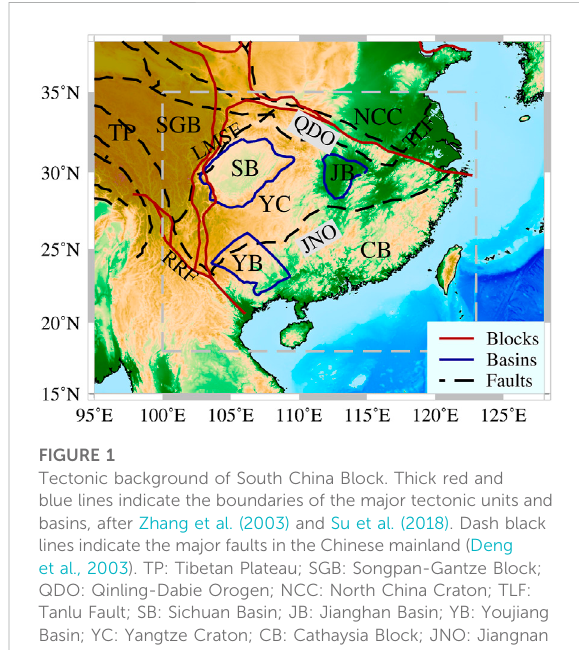
FIGURE 1 Tectonic background of South China Block. Thick red and blue lines indicate the boundaries of the major tectonic units and basins, after Zhang et al. (2003) and Su et al. (2018). Dash black lines indicate the major faults in the Chinese mainland (Deng et al., 2003). TP: Tibetan Plateau; SGB: Songpan-Gantze Block; QDO: Qinling-Dabie Orogen; NCC: North China Craton; TLF: Tanlu Fault; SB: Sichuan Basin; JB: Jianghan Basin; YB: Youjiang Basin; YC: Yangtze Craton; CB: Cathaysia Block; JNO: Jiangnan Orogen; RRF: Red River Fault; LMSF: LongMenShan